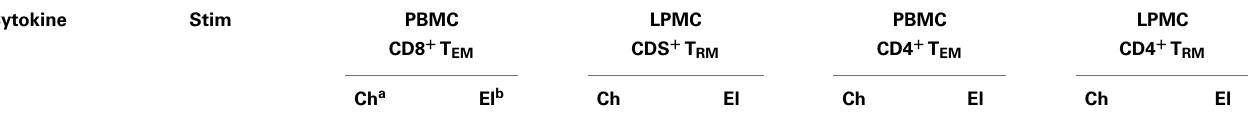
Table 3 | Summary of gastric LPMCT RM cells and PBMCT EM (CD4 + and CD8 + ) responses between children and the elderly to adults